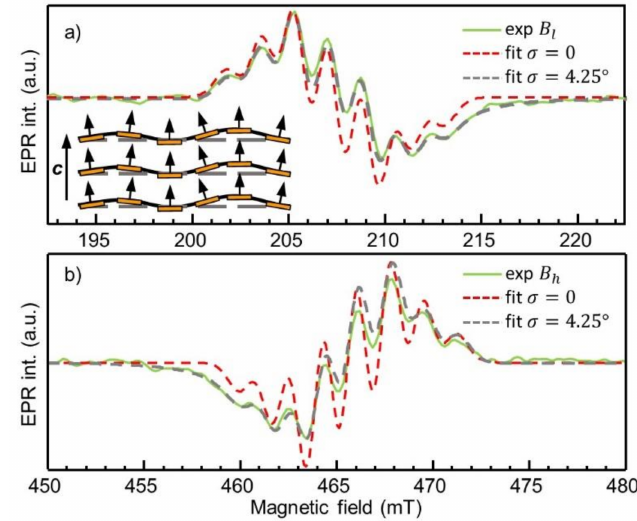
Figure 4. The fine-structure lines B l ( a ) and B h ( b ) from Figure 3 are shown in the enlarged scale with solid green-colored lines. Red dashed lines show the simulation of the B l and B h when only A = 47 MHz HF interaction constant with three equivalent 14 N atoms is considered. The same simulation is shown by a grey color, but taking into account broadening mechanism through the standard deviation σ of the hBN layers from the plane perpendicular to the c -axis by σ = 4.25 ◦ . Inset in ( a ) is a sketch of hBN layers misalignment in angle relative to the c -axis. Grey dashed lines show the perfect alignment of 2D layers. The brownish rectangles provide an overview of the deviation of basal planes from perpendicular orientation to the c